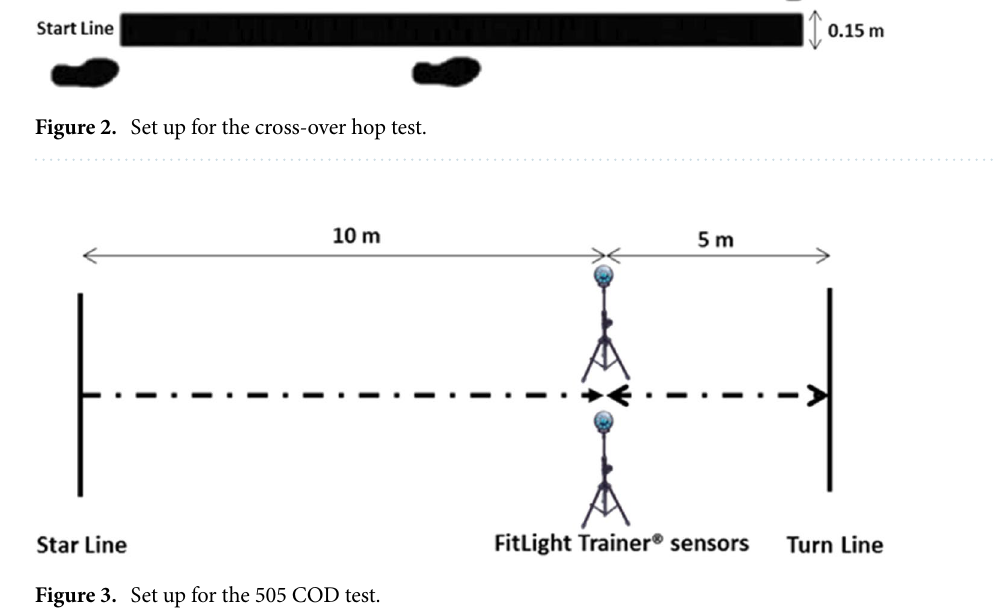
Figure 3. Set up for the 505 COD